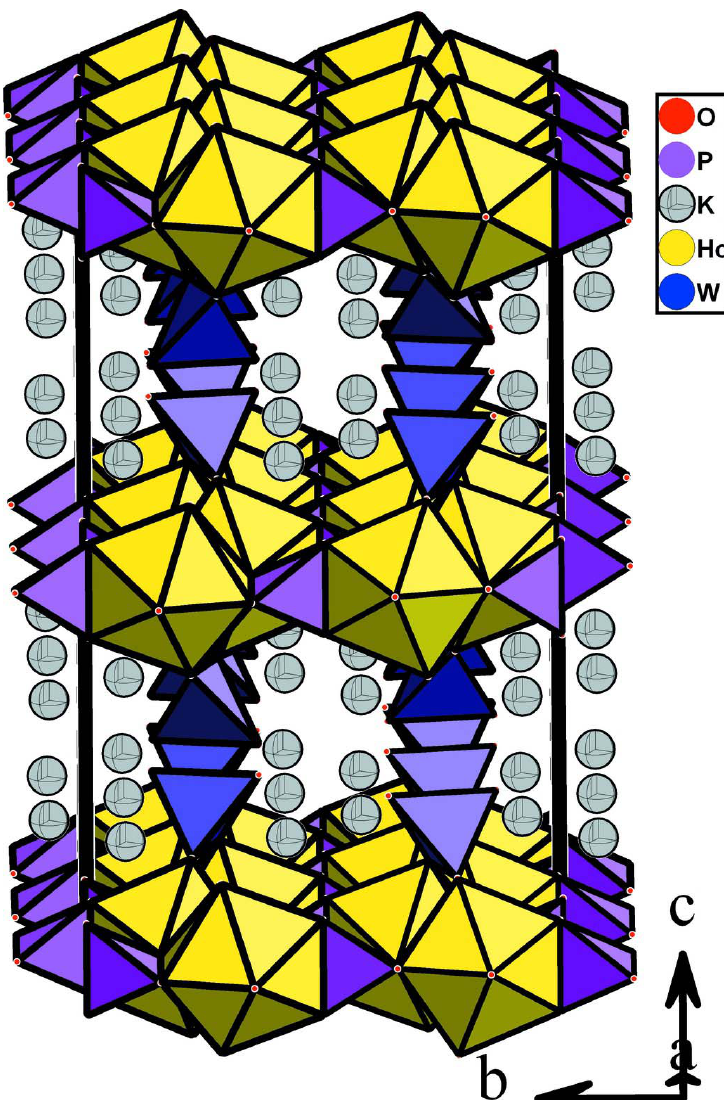
Figure 1 The layered structure of K